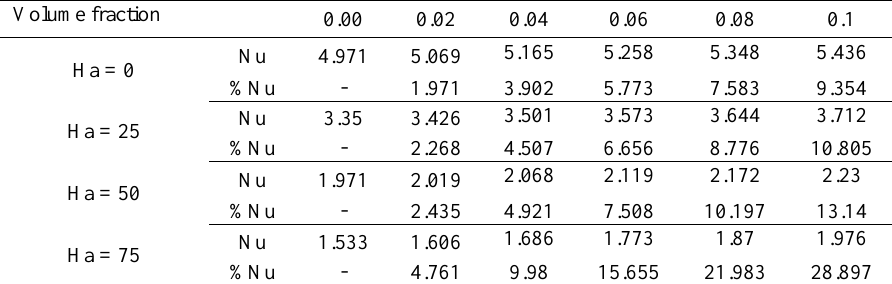
Table 4. Average Nusselt as a function of volume fraction and Hartmann number for